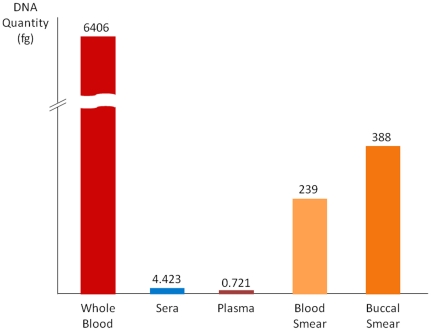
Threshold for DNA detection among different sampling types.